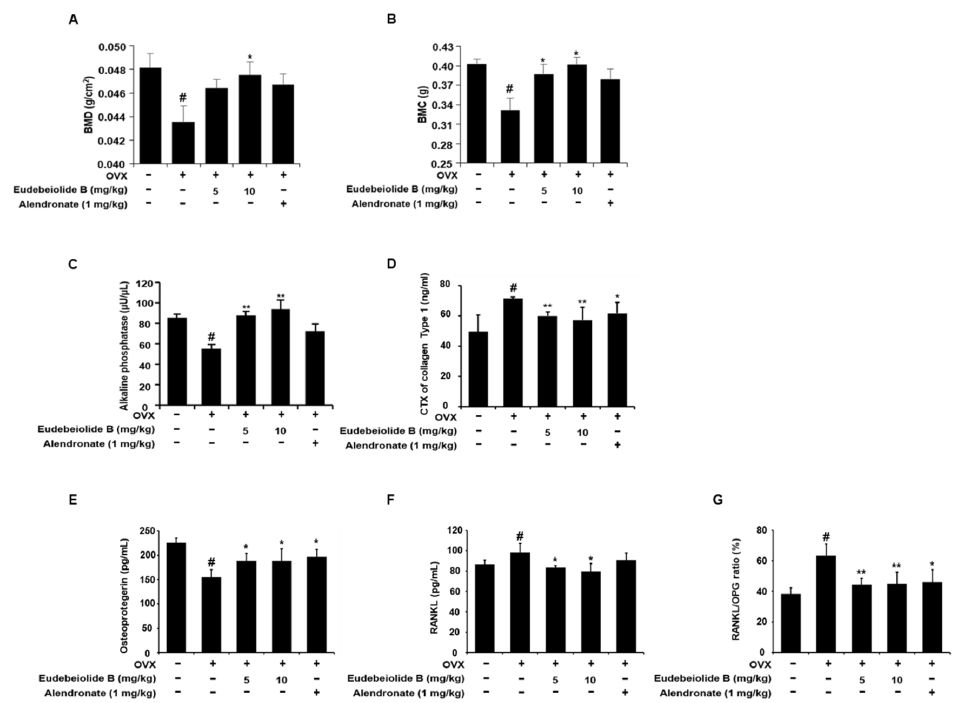
Figure 5. Bone mineral density BMD, bone mineral content BMC and biochemical serum analysis of the sham-operated, OVX + vehicle, OVX + eudebeiolide B-treated and OVX + alendronate-treated mice. ( A ) BMD and ( B ) BMC of the whole body were analyzed using DEXA ( n = 6). The serum levels of ( C ) ALP, ( D ) c-terminal telopeptide of type 1 collagen (CTX), ( E ) osteoprotegerin (OPG) and ( F ) RANKL were determined by ELISA ( n = 6). ( G ) RANKL/OPG ratio was calculated ( n = 6). Data are expressed as the means ± S.D. # p < 0.05 versus the sham group obtained through the unpaired Student’s t -test; * p < 0.05, ** p < 0.01 versus the only-OVX-treated group obtained through one-way ANOVA followed by Dunnett’s